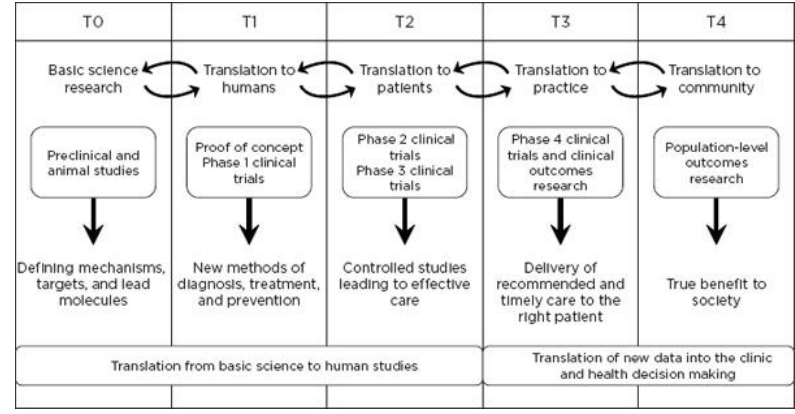
Figure 2. Operational phases of translational research in greater detail ( T0 – T4 ), Reprinted by permission from Macmillan Publishers Ltd: Nature Medicine [3] Copyright 2012 [3].